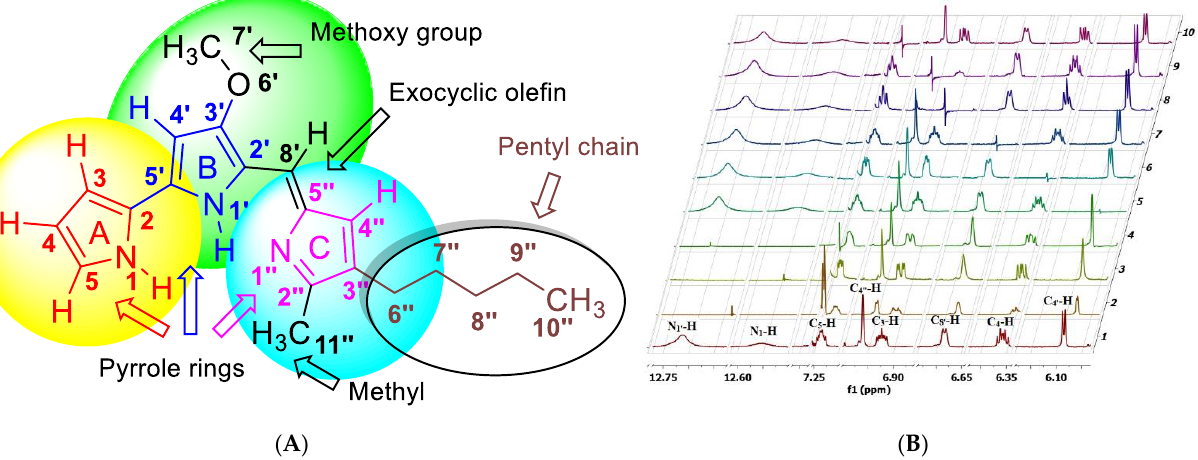
Figure 1. NMR analysis of prodigiosin. ( A ) Chemical structure of prodigiosin indicating the num- bers and positions of the individual atoms. ( B ) 1 H- 1 H-Homonuclear decoupling experiments of pro- digiosin. (1) Non-decoupled spectrum; (2) multifrequency decoupling of N 1 -H and N 1 ’ -H; (3) irradi- ation of N 1 -H; (4) irradiation of N 1 ’ -H; (5) irradiation of C 4 ’ -H; (6) irradiation of C 4 -H; (7) irradiation of C 8 ’ -H; (8) irradiation of C 3 -H; (9) irradiation of C 4 ’’ -H; (10) irradiation of C 5 -H. At the time of its discovery, only ultraviolet-visible absorption spectrophotometry and infrared spectroscopy were used to confirm the synthesis of prodigiosin in V.